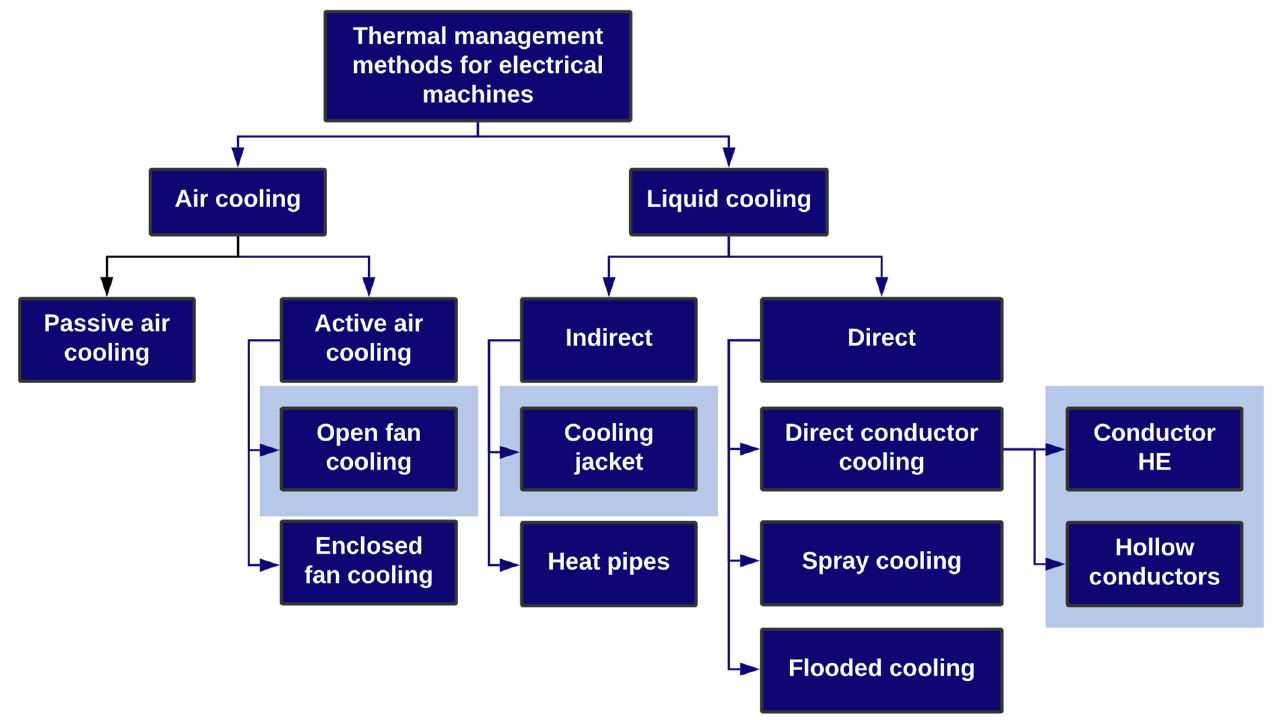
Figure 5. Various cooling methods for electrical machines. The light blue shading indicates that an additively manufactured solution for an electrical machine exists in the literature.